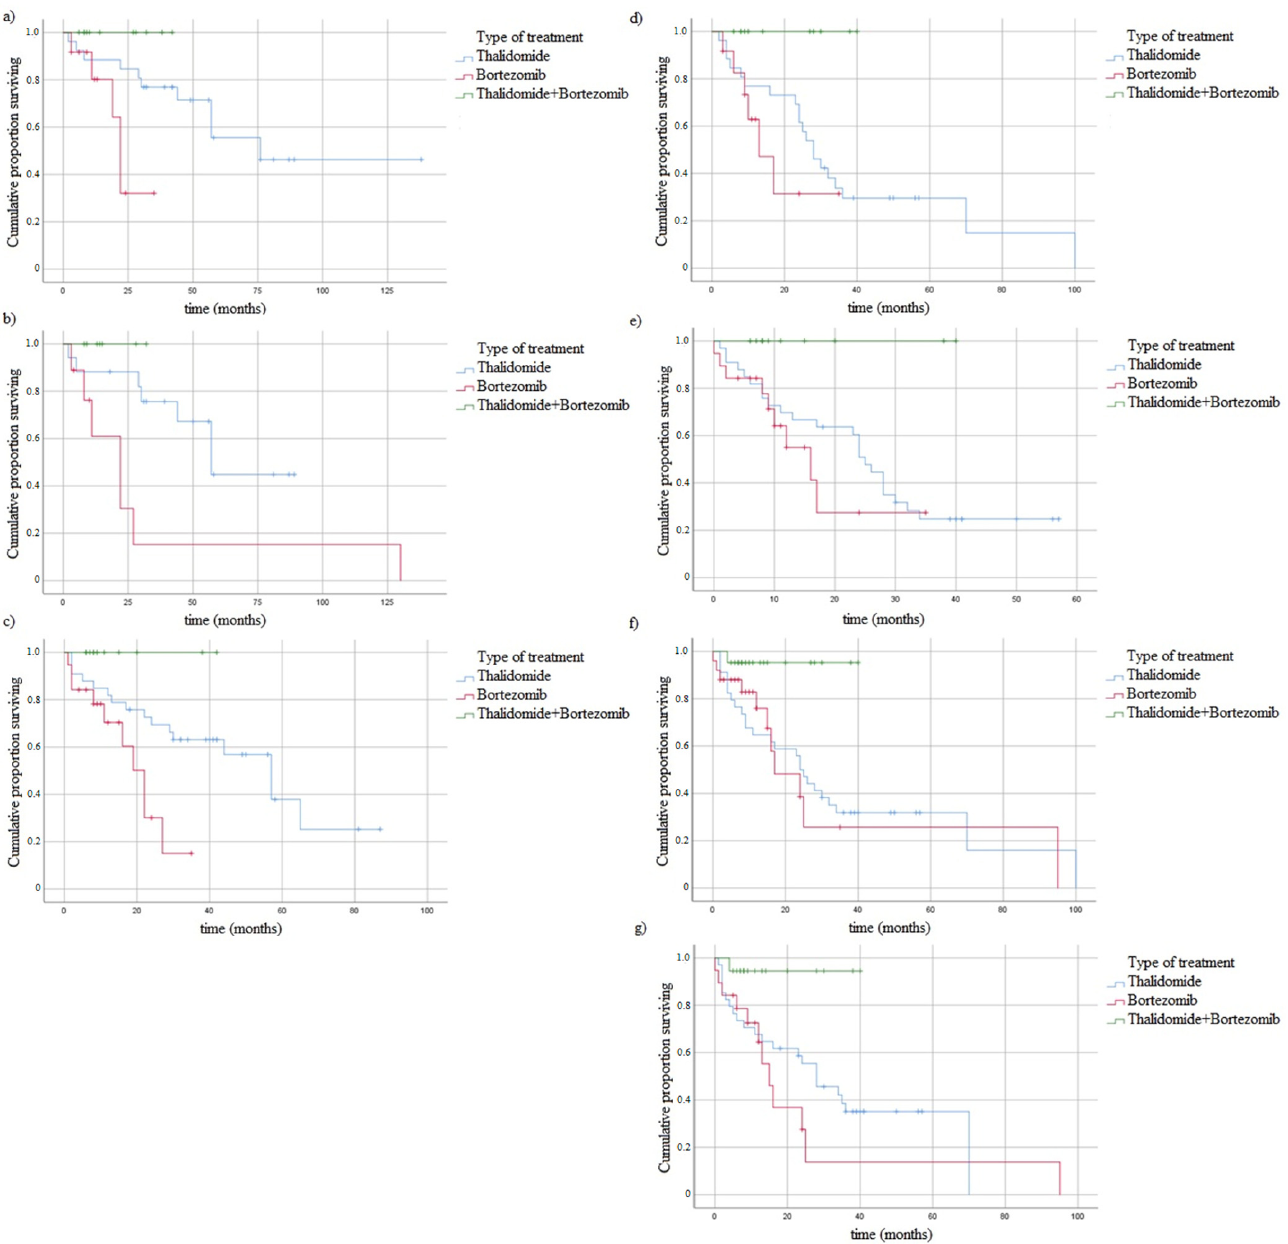
Figure 5. Kaplan ‐ Meier analysis of surviving taking into account the type of treatment: ( a ) CT genotype of ABCB1 1236C > T (OS and treatment), log ‐ rank test p = 0.014; ( b ) GT genotype of ABCB1 2677G > T/A (OS and treatment), log ‐ rank test p = 0.013; ( c ) CT genotype of ABCB1 3435C > T (OS and treatment), log ‐ rank test p = 0.005; ( d ) CT genotype of ABCB1 1236C > T (PFS and treatment), log ‐ rank test p = 0.021; ( e ) CT genotype of ABCB1 3435C > T (PFS and treatment), log ‐ rank test p = 0.033; ( f) wt/wt genotype of CYP1A1 6235T > C (PFS and treatment), log ‐ rank test p = 0.016; ( g) wt/wt genotype of CYP1A1 4889A > G (PFS and treatment), log ‐ rank test p = 0.021.